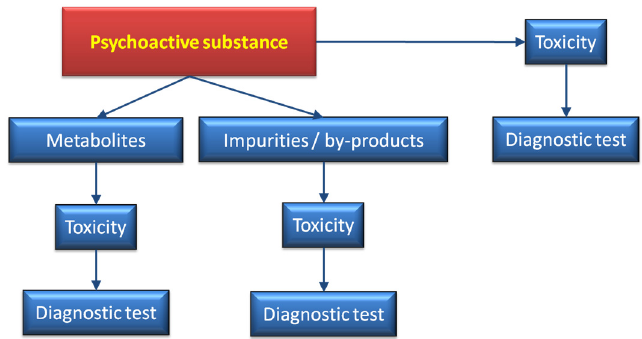
Figure 10. The proposed analytical strategy allowing for complete analytical profile of drug.